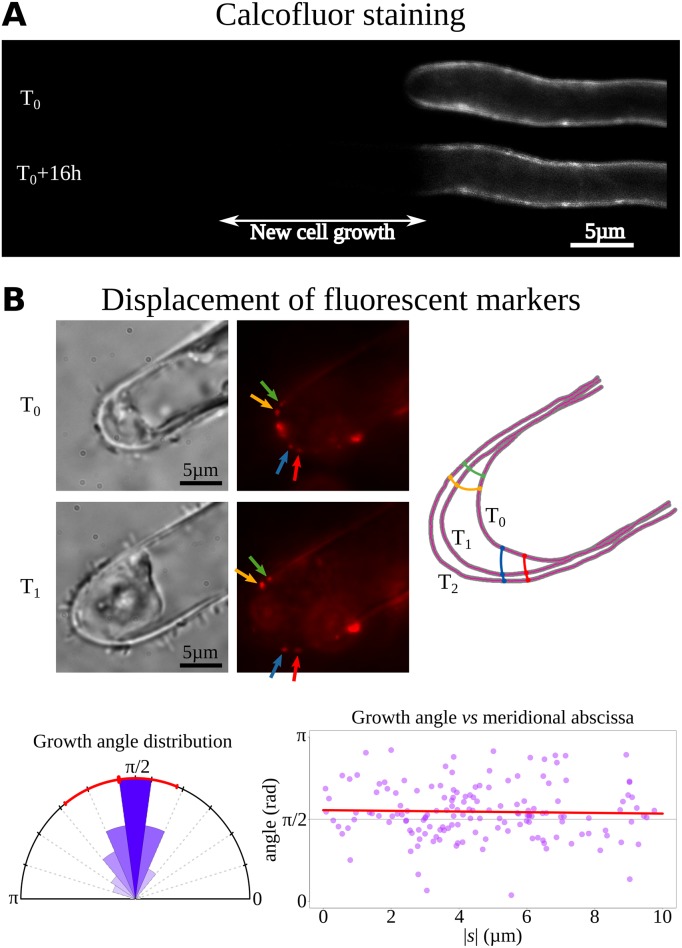
Position and direction of cell wall expansion during growth.(A) Pulse-chase experiment using calcofluor-white stain during growth. Filaments were washed to remove the calcofluor-white immediately after staining and observed again after 16 h. The dark area thus corresponds to recently deposited cell materials. (B) Orthogonal growth in the apical cell. (Top) Cell wall deformation at the apex of an apical cell during growth, as visualized by the displacement of fluorescent microspheres 24 h after applying them to the cell surface. (Left) Bright-field pictures; (right) corresponding confocal pictures showing the microspheres as red fluorescent dots. Note the progressive displacement of four microspheres from the dome toward the shank of the cell as the cell grows. Bar = 5 μm. (Bottom) Distribution of angles between the cell surface and the growth direction (sectors); (left) red line and tick marks denote the mean and standard deviation. (Right) Angle values plotted as a function of the meridional abscissa |s|, showing that the angle is stable regardless of position in the dome (red line: linear regression). Data are available as Supporting Information S1 Data. S1 Fig illustrates a representative sample of the data.